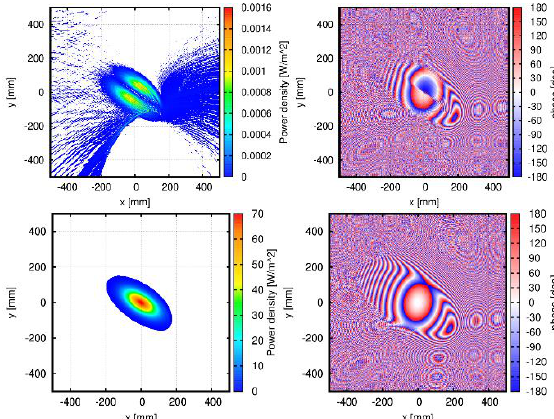
Fig. 8. Field of the beam U1 after the mirror UA